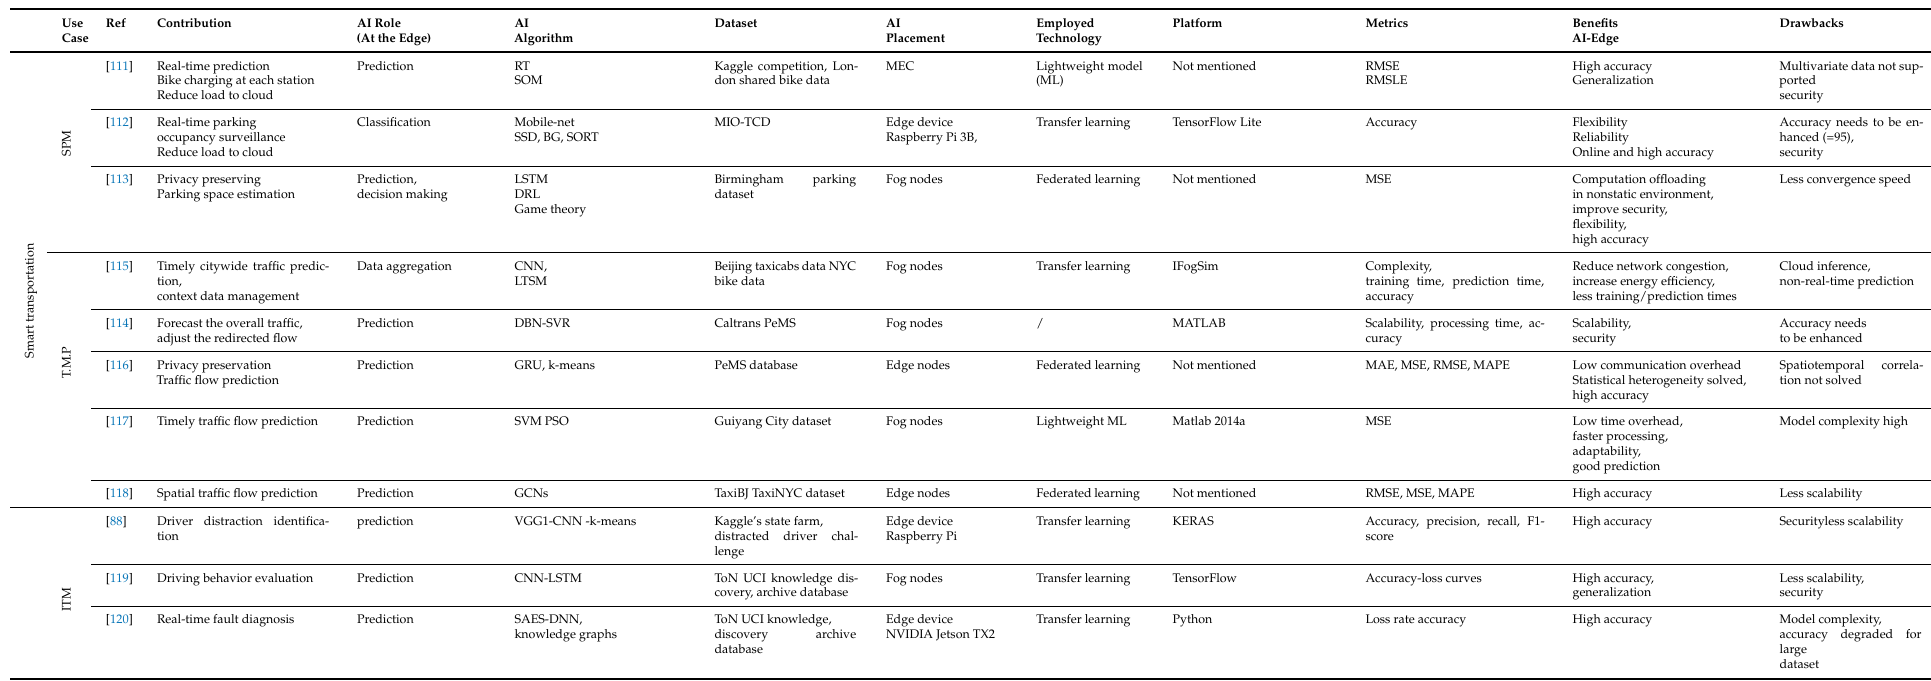
Table 9. Qualitative comparison of smart transportation-related